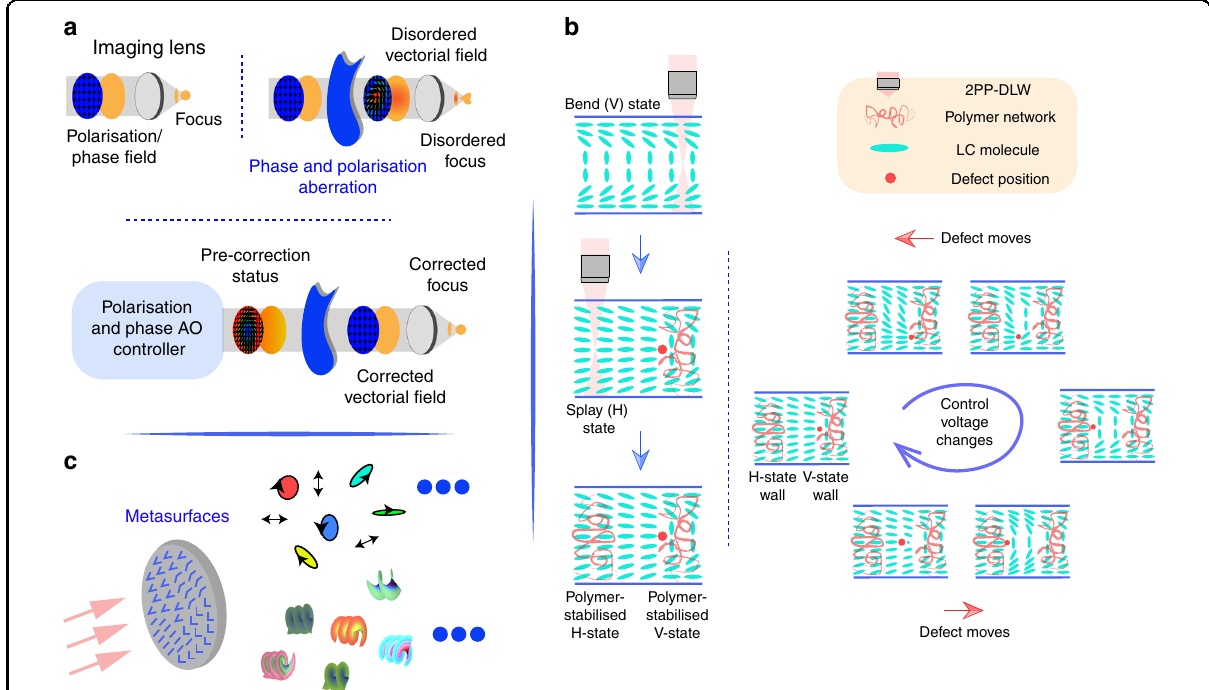
Fig. 5 Advanced optical technique assisting structured light multiplexing. a A perfect optical system and an aberrated system, as well as vectorial-AO-enhanced optical system. b Electrically tunable disclination line — visualisation of the movement of different topological defect states under different control voltages. c Metasurface-based techniques for complex beam